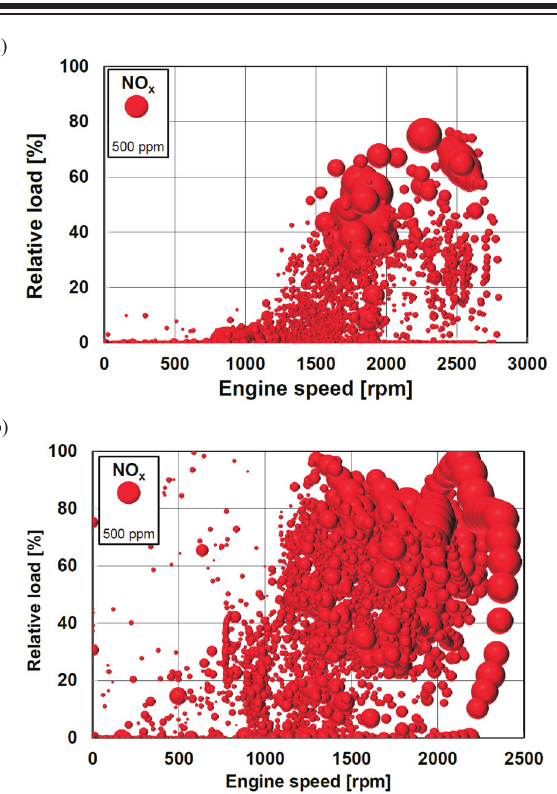
Fig. 7. Road emission values (a) and conformity factors (b) determined during road tests for a vehicle equipped with a gasoline engine